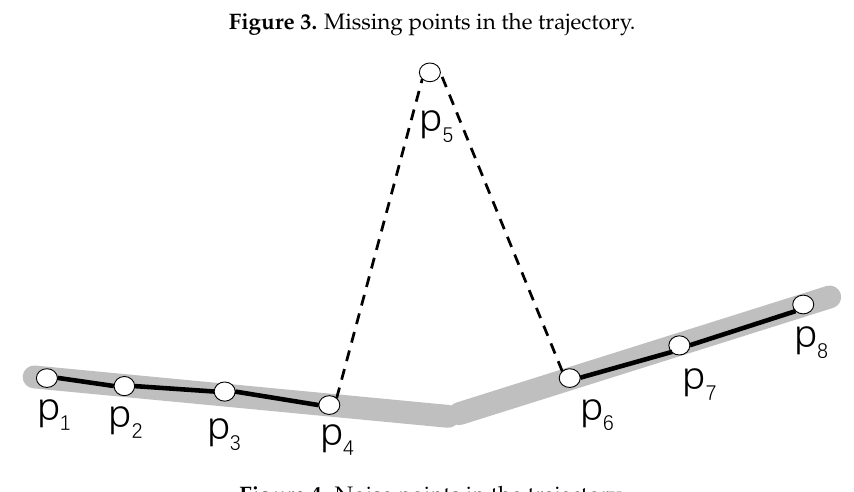
Figure 4. Noise points in the trajectory.